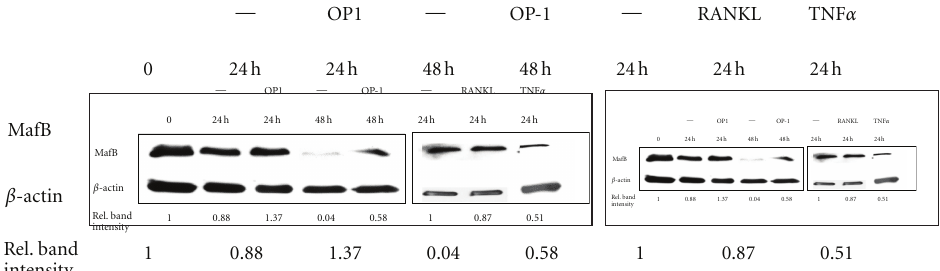
Figure 5: E ff ect of culture conditions and OP-1 on MafB expression: Monocytes were cultivated with or without OP-1 for the times indicated and MafB was determined by Western blotting. Actin was used as loading control. In another experiment, the e ff ect of RANKL or TNF α on MafB expression was assessed